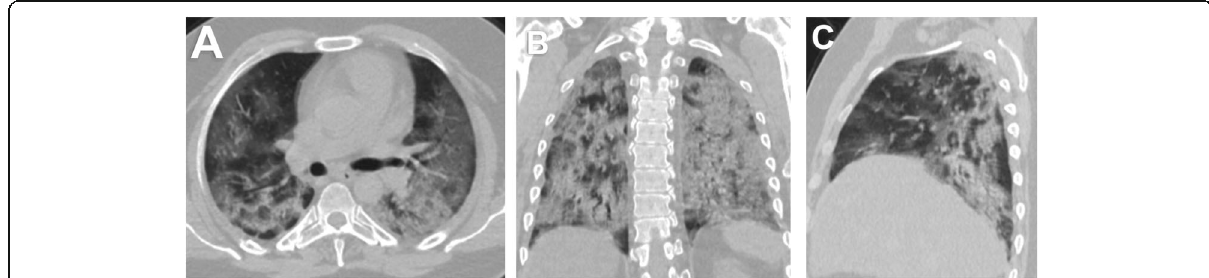
Fig. 3 A 44-year-old male patient. A axial, B coronal, and C sagittal chest CT images show bilateral diffuse mainly peripheral ground-glass opacities and consolidation with severe pulmonary involvement (50-75%) corresponds to current chest CT score 19 and simple chest CT score 4 (severe affection) and. The patient survived